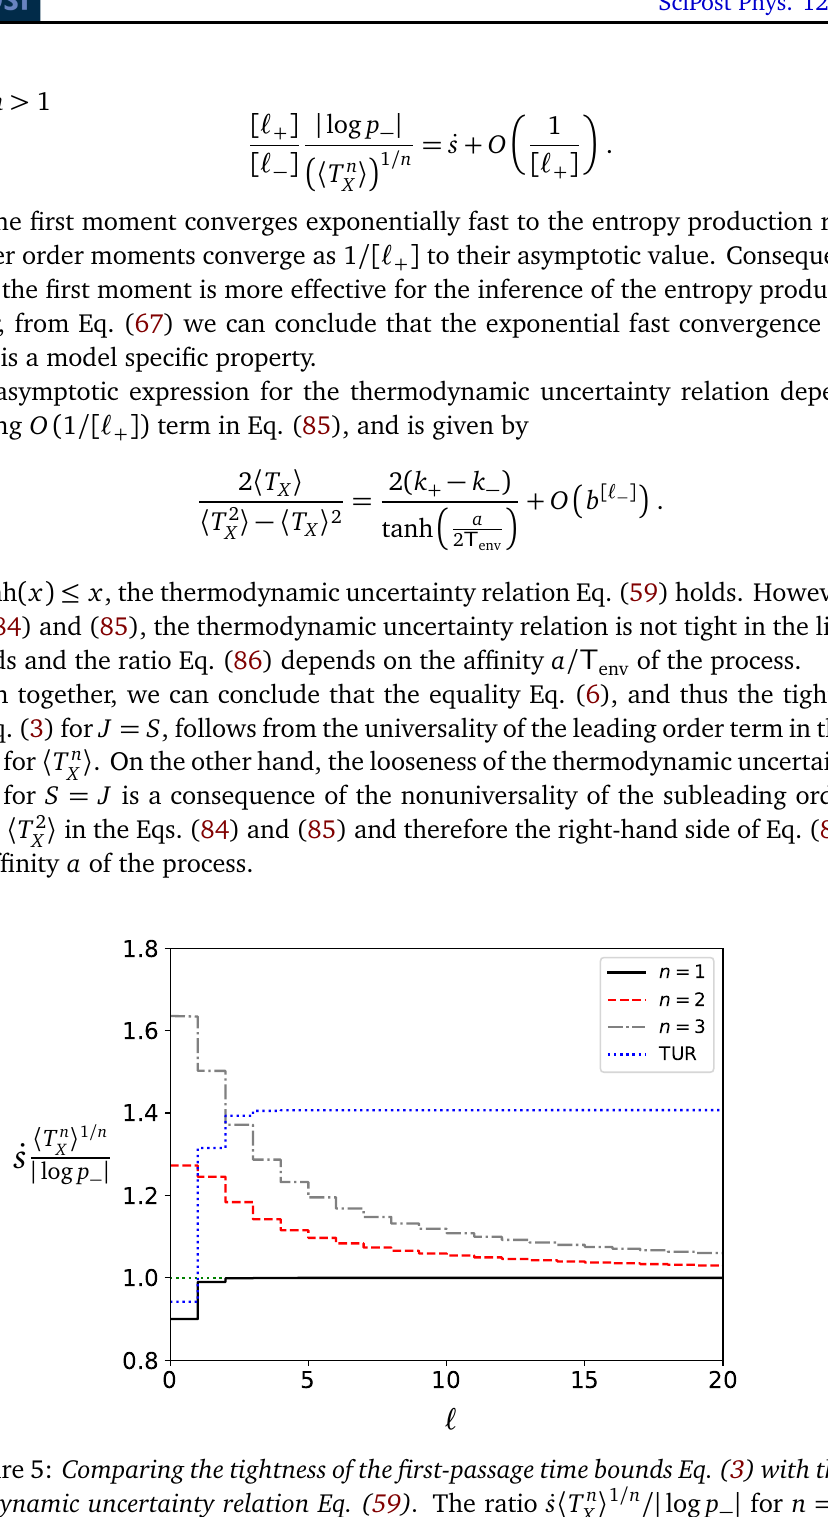
〉 1 / n / | log p | for n = 1,2,3 − X 〉 − 〈 T 〉 2 ) / ( 2 〈 T 〉 ) are plot- X X X